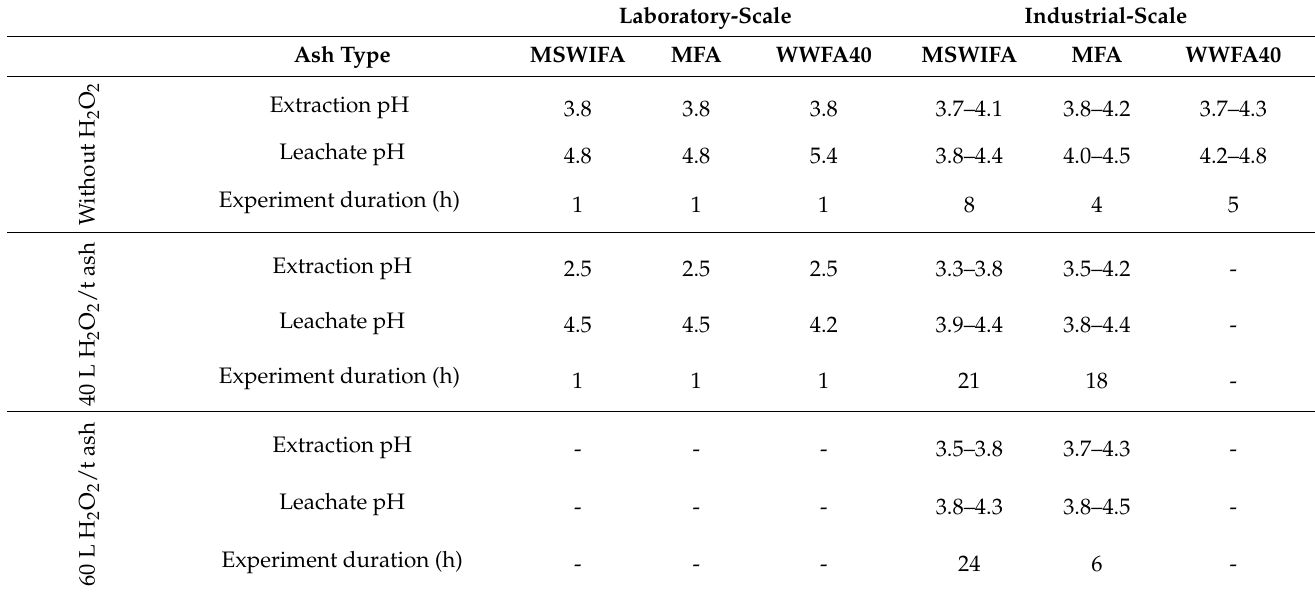
Table 1. Experimental setups for laboratory- and industrial-scale experiments. Laboratory-Scale